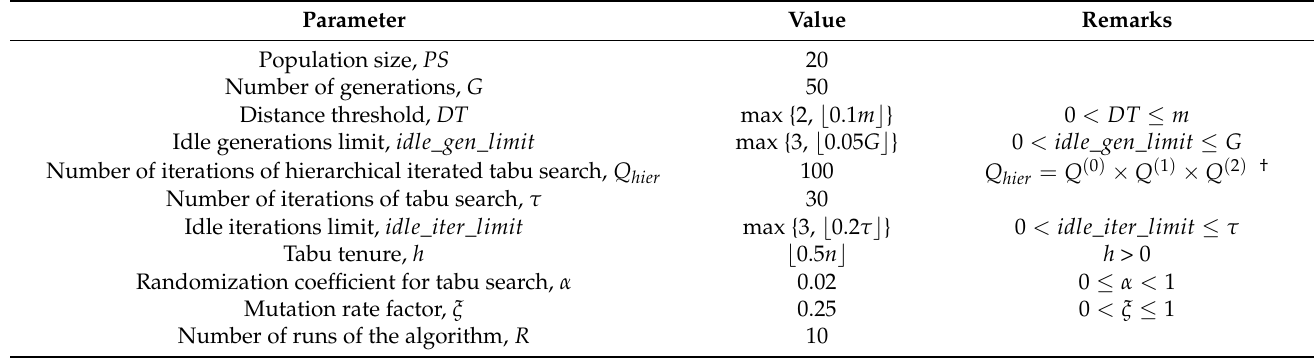
Table 1. Values of the control parameters of the hybrid genetic algorithm used in the experiments.